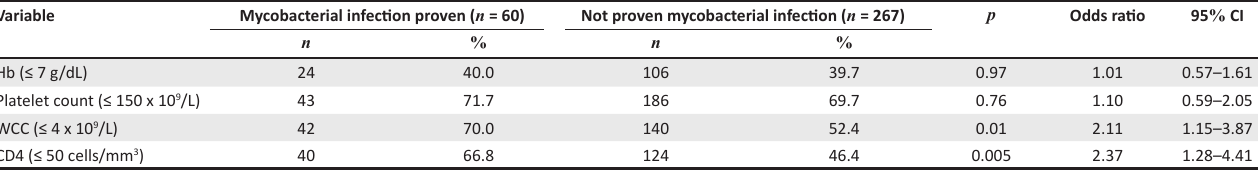
TABLE 4: Predictors of mycobacterial infection on bone marrow examination.